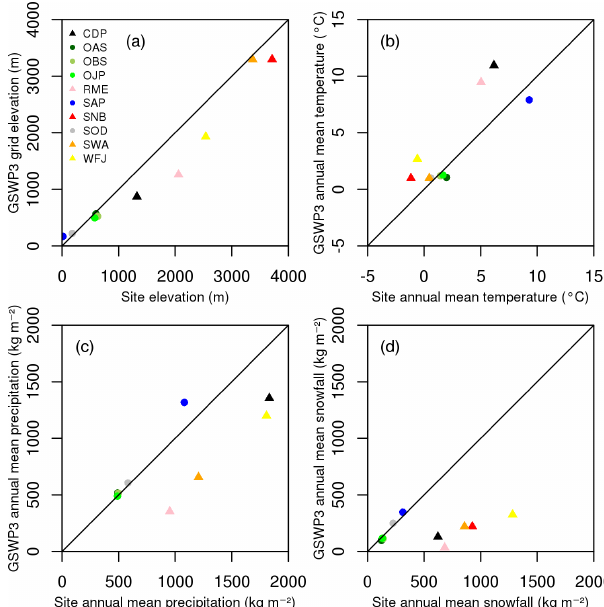
Figure 9. Comparisons between elevations (a) , temperatures (b) , total precipitation (c) , and snowfall (d) at ESM-SnowMIP refer- ence sites and corresponding GSWP3 grid cells. Triangles identify mountain